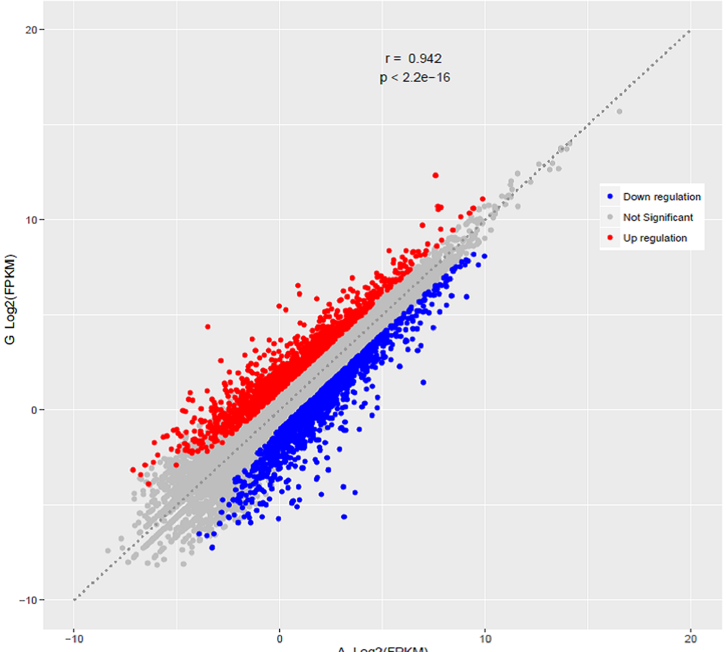
Fig 4. Comparison of differentially expressedgenes between the two breeds. Scatter plot showingthe correlationof gene abundance.Red points represent genesupregulatedby at least two fold at FDR (cid:20) 0.05, blue points represent genesdownregulatedat the same thresholds, and grey dots indicate transcripts that did not changesignificantly.